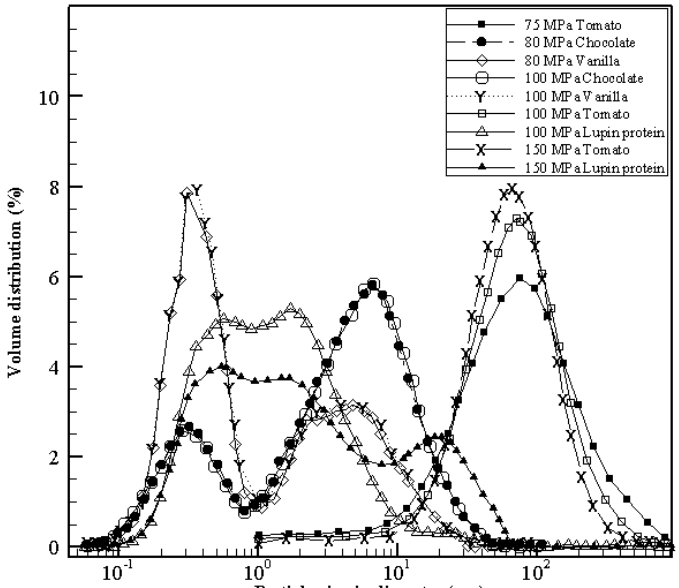
Figure 4: Particle size distribution of chocolate- and vanilla-based products, tomato and lupin protein subjected to 70-150 MPa [1, 5,